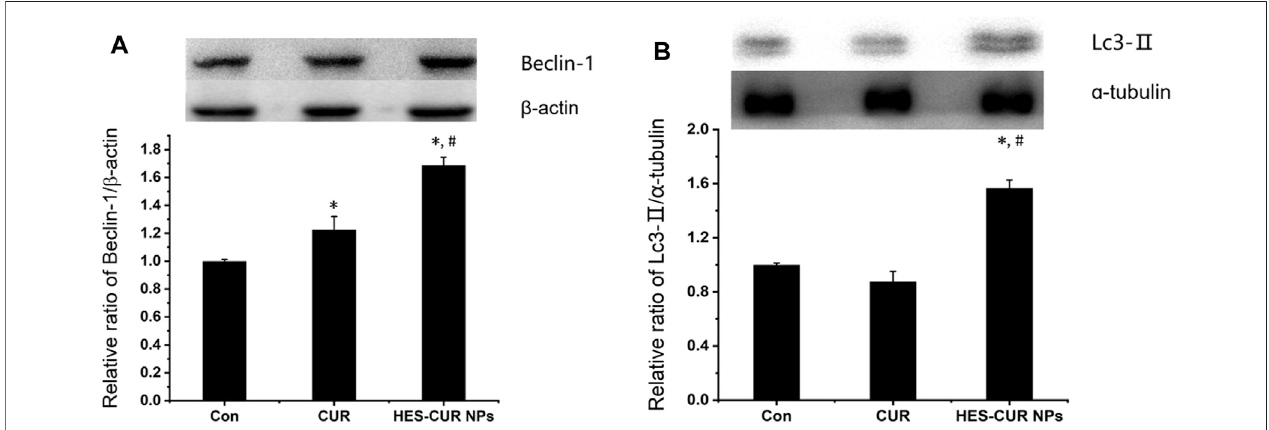
FIGURE 6 | Effects of CUR and HES-CUR NPs on (A) Beclin-1 and (B) LC3-II expression levels. Data were expressed as mean ± SD, and the experiment was repeated thrice. * p < 0.05 indicated signi fi cant differences from the control group; # p < 0.05 indicated signi fi cant differences from the CUR group.